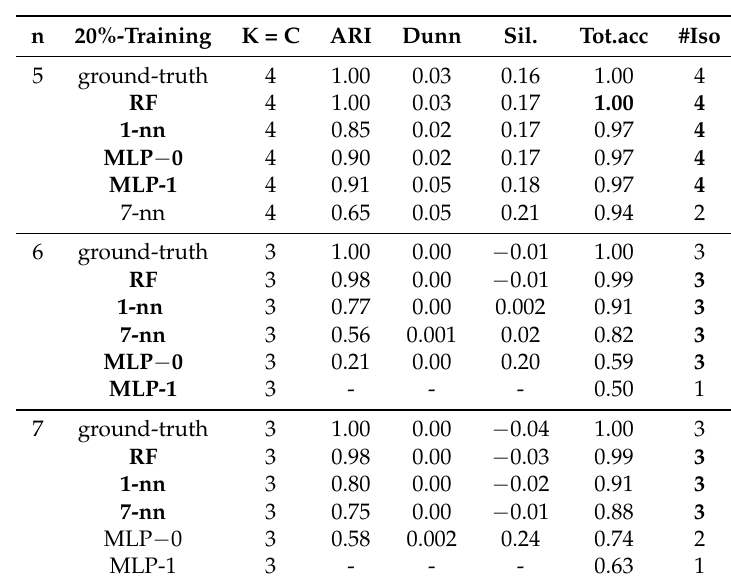
Table 3. Classification approaches applied to pattern discovery, ordered by well-isolated pattern numbers (#Iso) with performance indicators for test database: Adjusted Rand Index (ARI), Dunn and Silhouette (Sil.) indexes, total accuracy (Tot.acc) and the number of clusters K . Bold: #Iso = C . 0.00: non zero number (value with more 3 decimal). n is the dataset number. RF = Random